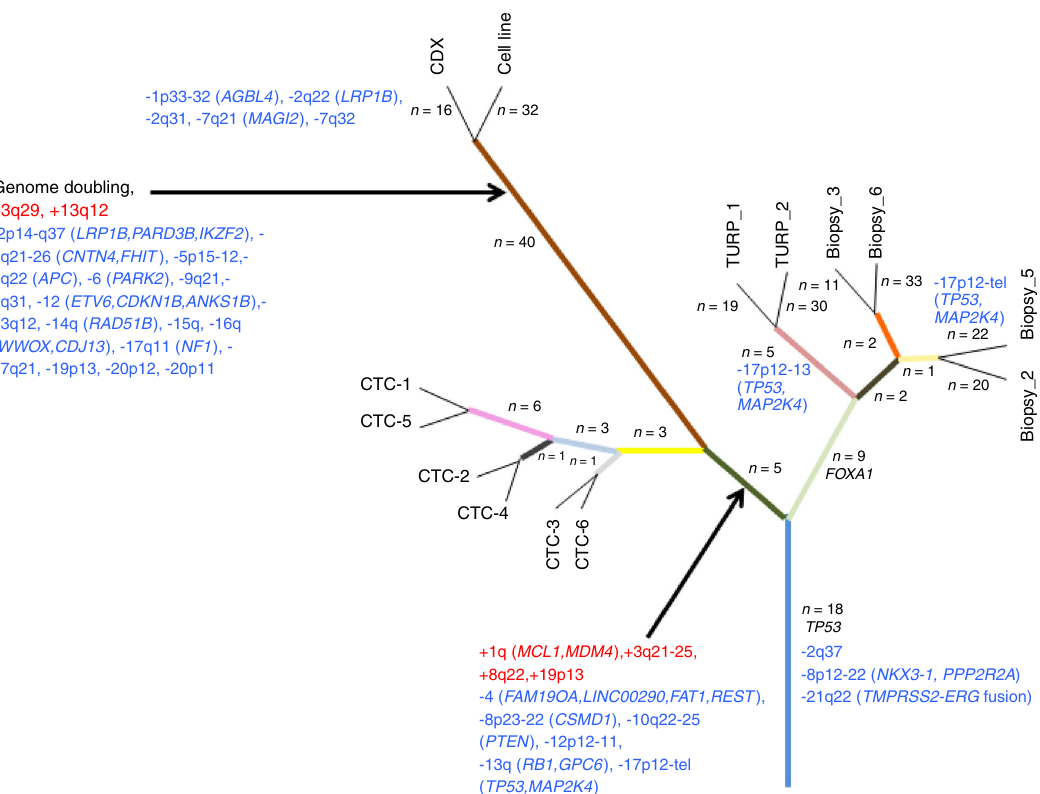
Fig. 6 Phylogeny of the CDX and the CDX-derived cell line. The numbers of mutations (in dark) and the CNA (loss in blue and gain in red) are mentioned on the branches of the tree. Only genes bearing driver alterations (mutations or CNAs) are indicated.